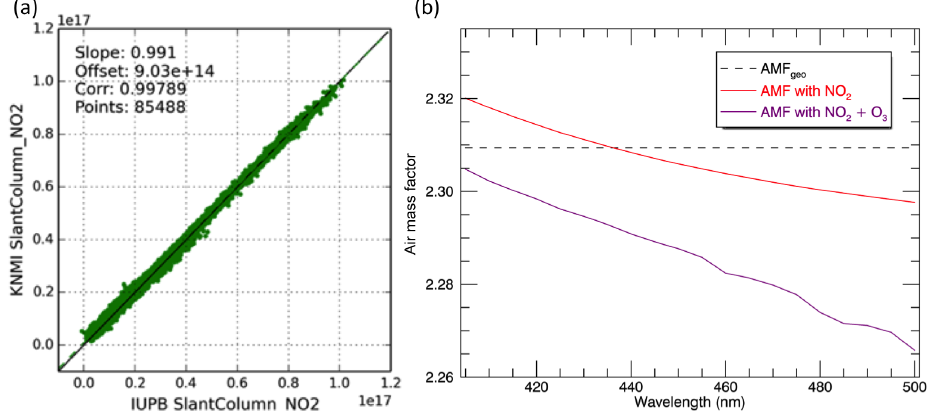
Figure 4. (a) Correlation plots of IUP Bremen (425–497nm fitting window) and KNMI (405–465nm) NO 2 slant columns retrieved using preferred fit settings for OMI orbit OMIL2_2005m0202t0339, including only pixels with SZA <88 ◦ and intensity <1.1 × 10 14 . (b) Wave- length dependency of the total air mass factor for a scenario with SZA = VZA = 30 ◦ (geometrical AMF = 2.31), as calculated with DAK for a midlatitude standard atmospheric profile with a total NO 2 column of 5.9 × 10 15 moleculescm − 2 (mostly situated in the stratosphere) (red curve), and for the same midlatitude standard atmospheric profile but now with absorption by both NO 2 and O 3 (total column of 322DU, purple curve). Table 4. Recommended settings for the QA4ECV NO 2 spectral fitting for the retrieval of NO 2 slant columns from GOME, SCIAMACHY, OMI, and GOME-2(A) for generating a multi-decadal data record for the period 1995–2017. OMI GOME-2(A) SCIAMACHY GOME QDOAS